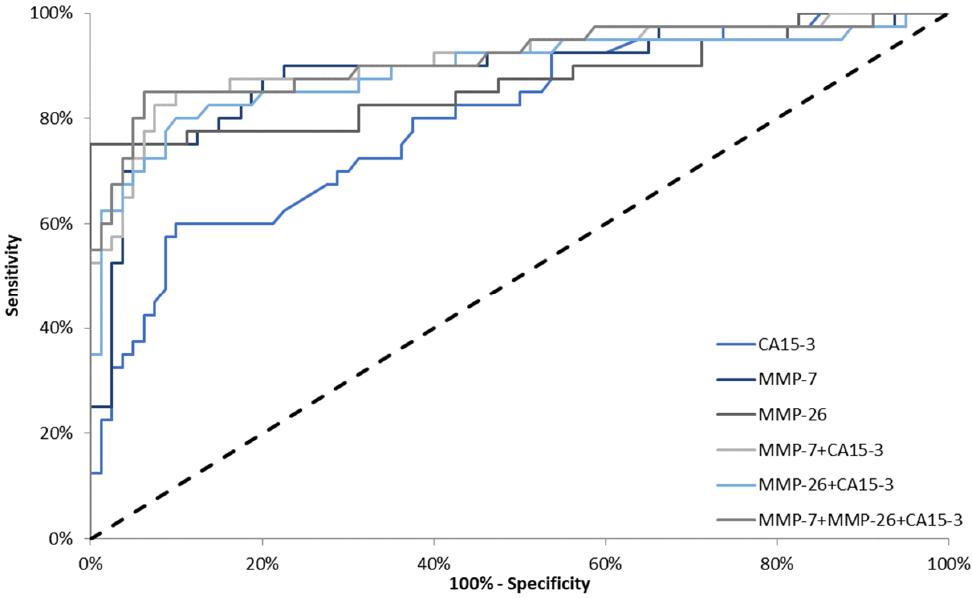
Figure 6. Diagnostic criteria of ROC curve in stages III and IV breast cancer (BC). CA 15-3—cancer antigen 15-3; MMP-7— matrilysin-1; MMP-26—matrilysin-2.